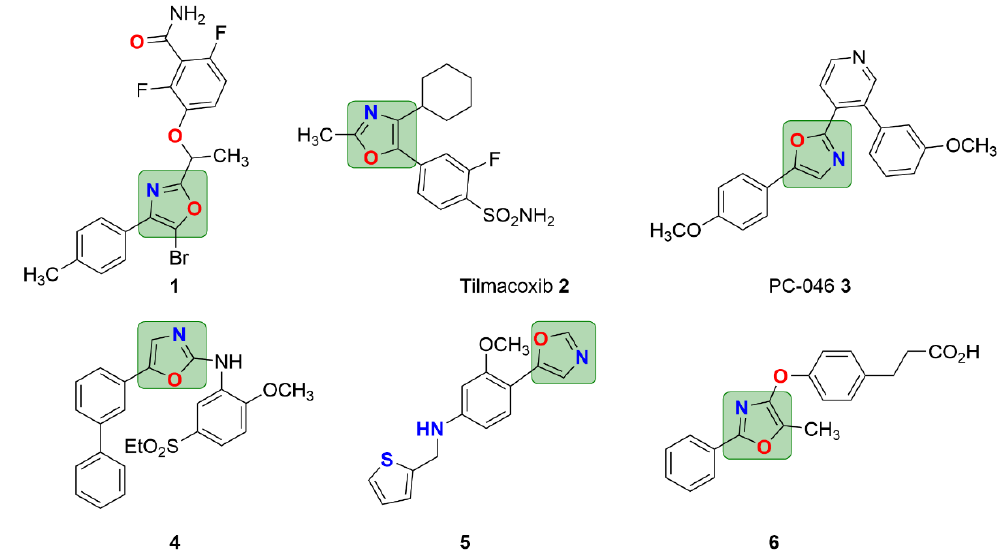
Figure 1. Representative examples of biological relevant compounds ( 1 – 6 ) bearing an oxazole framework.